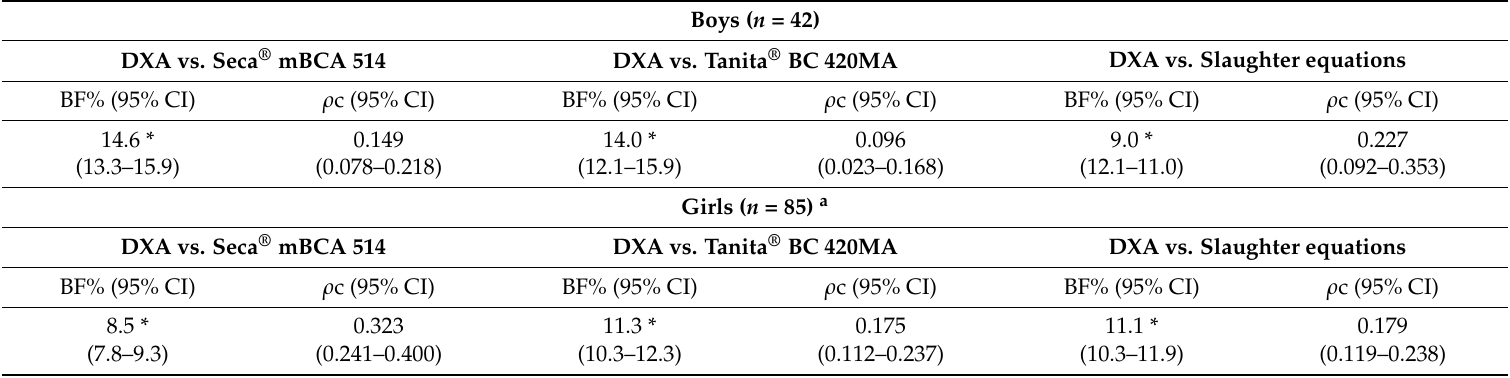
Table 2. Mean BF% difference and Lin’s concordance correlation coefficient between DXA and Seca ® mBCA 514, Tanita ® BC 420MA, and Slaughter skinfold-thickness equations by